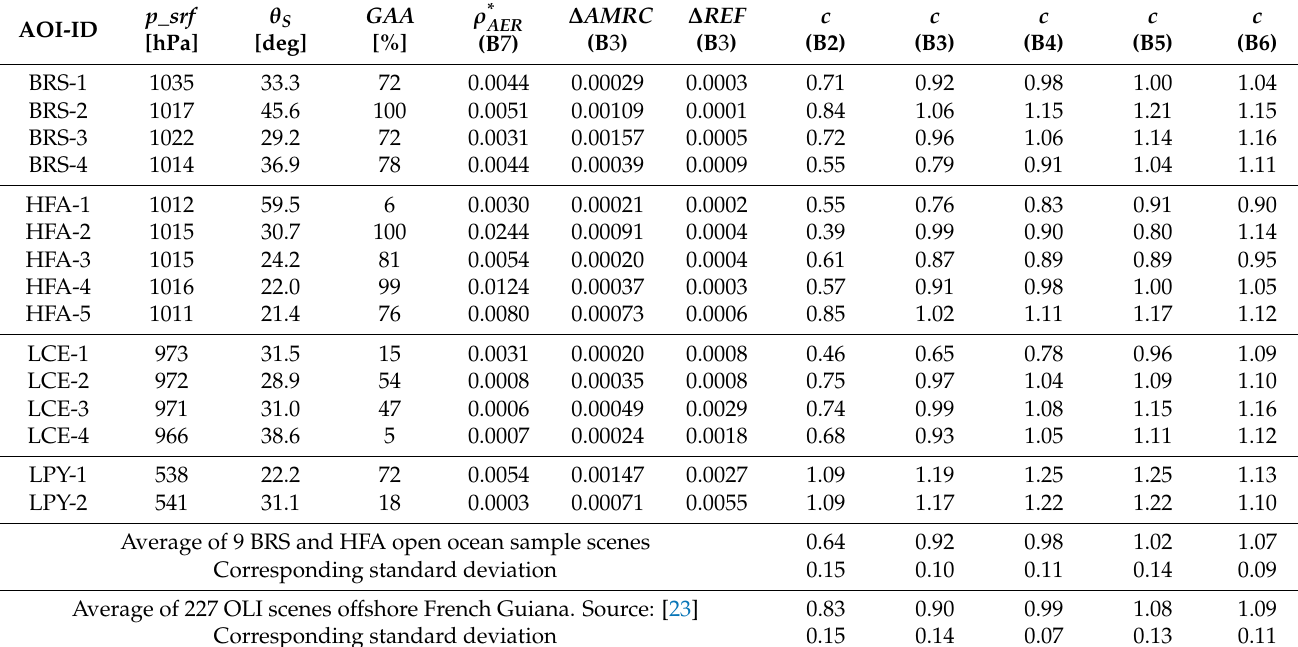
Table 4. GRCM retrieval results for the OLI sample scenes listed in Table 3. Atmospheric